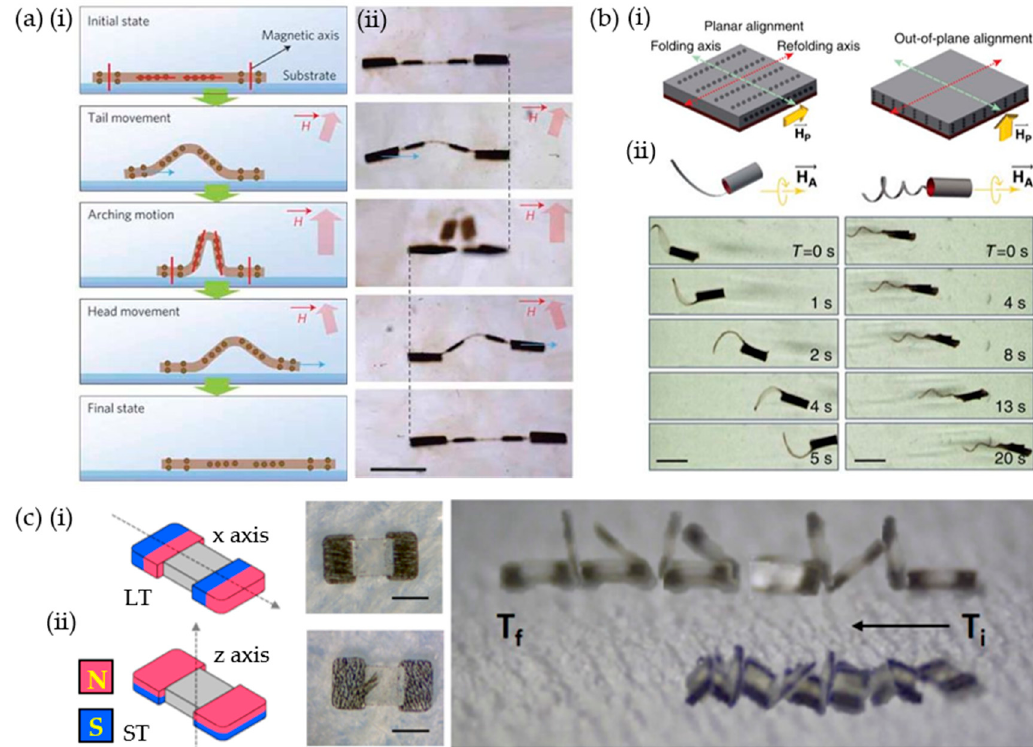
Figure 4. Directional motion induced by aligning magnetic components within a UV-curable polymer of soft robots. ( a ) ( i ) Schematic depiction of crawling motion, and ( ii ) optical snapshot images, including differently programmed head, tail (vertical alignments), and bodies (horizontal alignments) (scale bar: 100 µ m). ( b ) ( i ) Preparation strategies for folding of a bilayer hydrogel film including two orthogonal magneto-alignments, and ( ii ) a time-lapse image of its swimming motility (scale bar: 2 mm). ( c ) ( i ) Tumbling locomotion of axial alignments of the x-axis, and ( ii ) z-axis for lengthwise tumbling (LT) and sideways tumbling (ST), respectively (scale bar: 300 µ m). ( a ) Reproduced with permission [5]. Copyright 2011, Nature Publishing